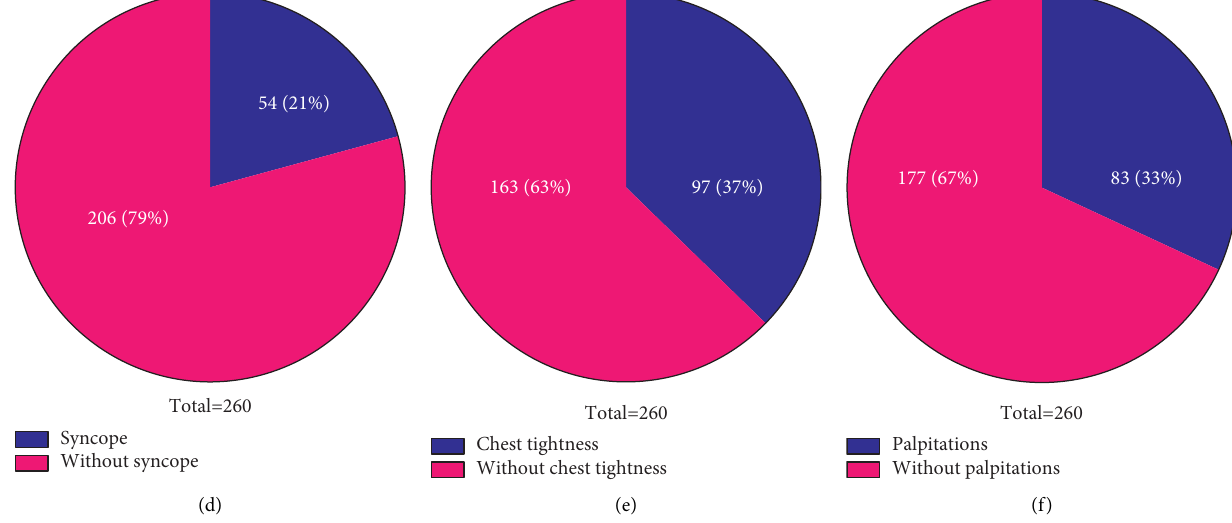
Figure 4: Symptoms recorded and analysis. (a) Blue represents patients accompanied with dizziness while red represents patients without dizziness. (b) Blue represents patients accompanied with migraine while red represents patients without migraine. (c) Blue represents patients accompanied with stroke or TIA while red represents patients without stroke or TIA. (d) Blue represents patients accompanied with syncope while red represents patients without syncope. (e) Blue represents patients accompanied with chest tightness while red represents patients without chest tightness. (f) Blue represents patients accompanied with palpitations while red represents patients without